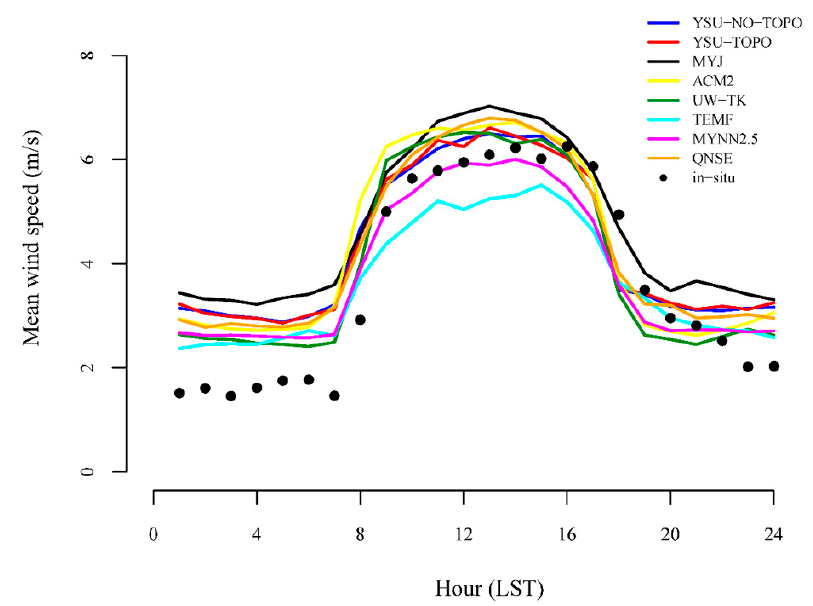
Figure 15. Diurnal variation in 10 m level wind speed as simulated by 7 PBL schemes and compared with in-situ observations at Piarco.